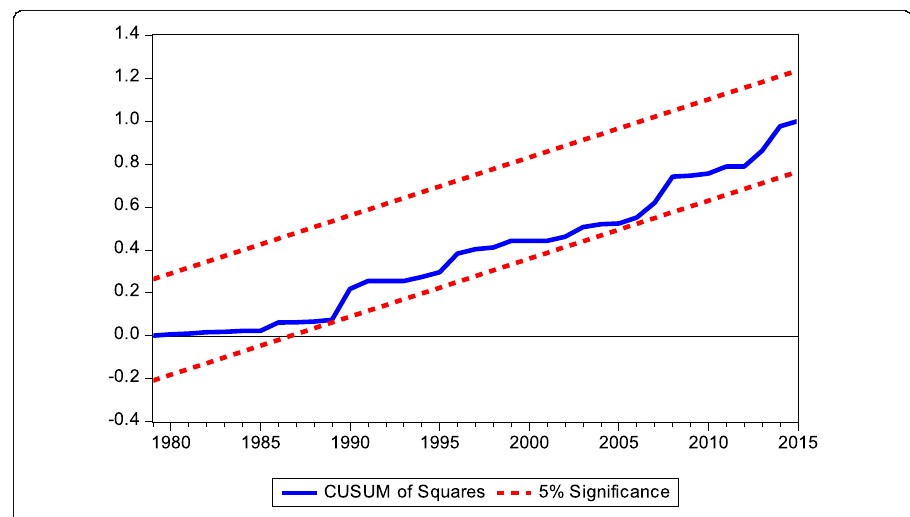
Fig. 2 Plot of Cumulative Sum of Squares of Recursive